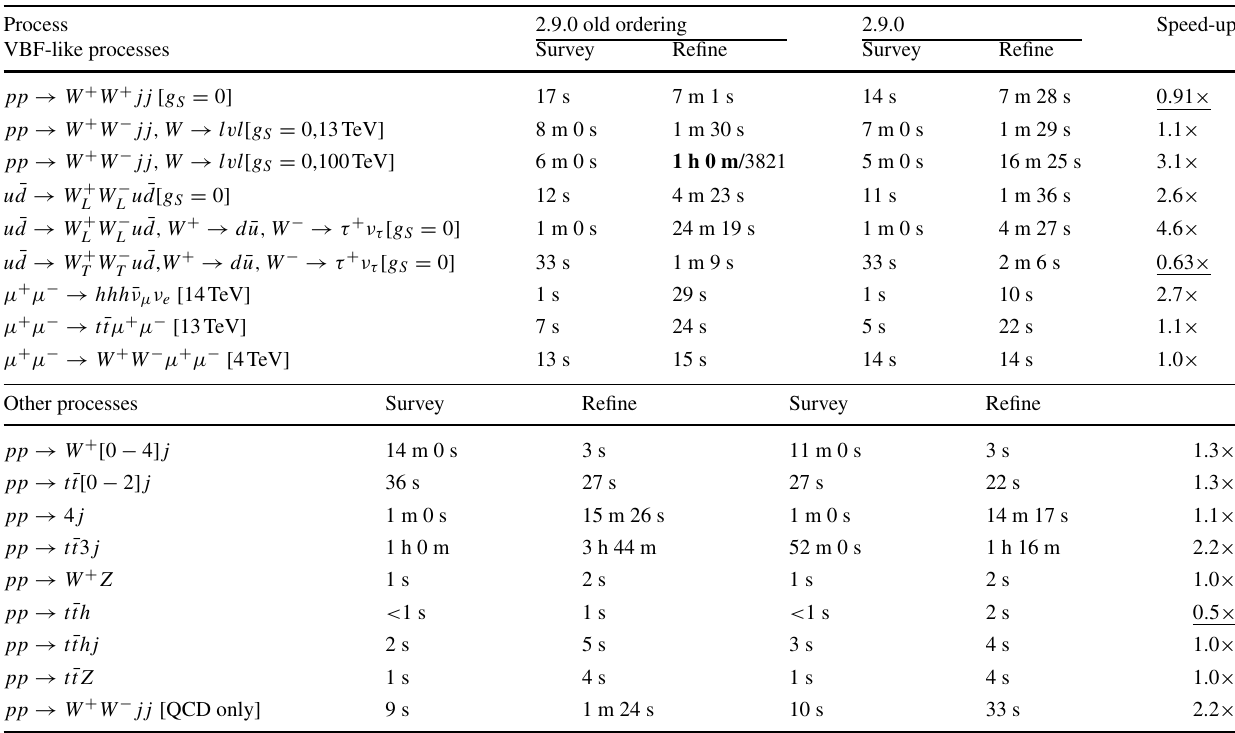
Table 5 Integration timing (time to solution) on a mac-book pro (quad- core 2016) to generate 10k events depending of the t -channel ordering strategy. If the generation fails to generate enough events the timing is